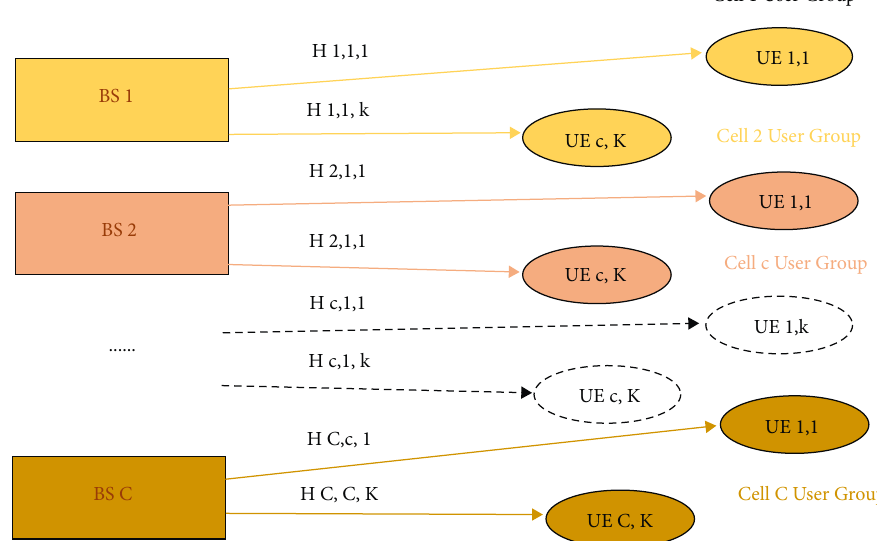
Figure 1: Interference broadcast channels or multicells, multiusers interference system model.